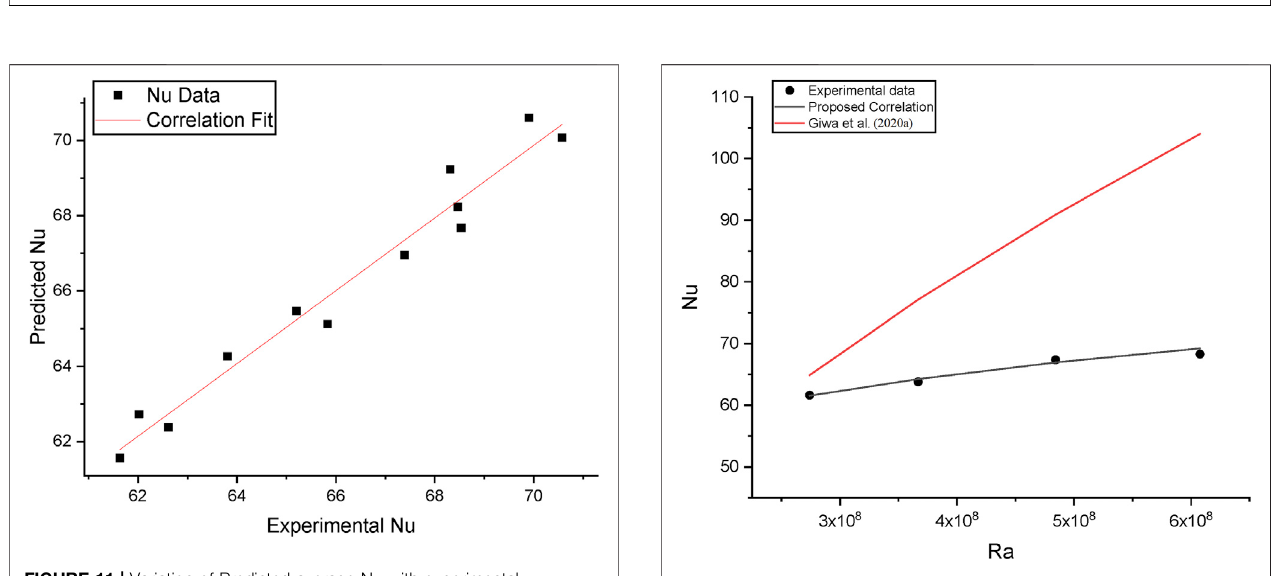
FIGURE 10 | The average Nusselt number of all the samples at different (A) Rayleigh number and (B) temperature gradients.